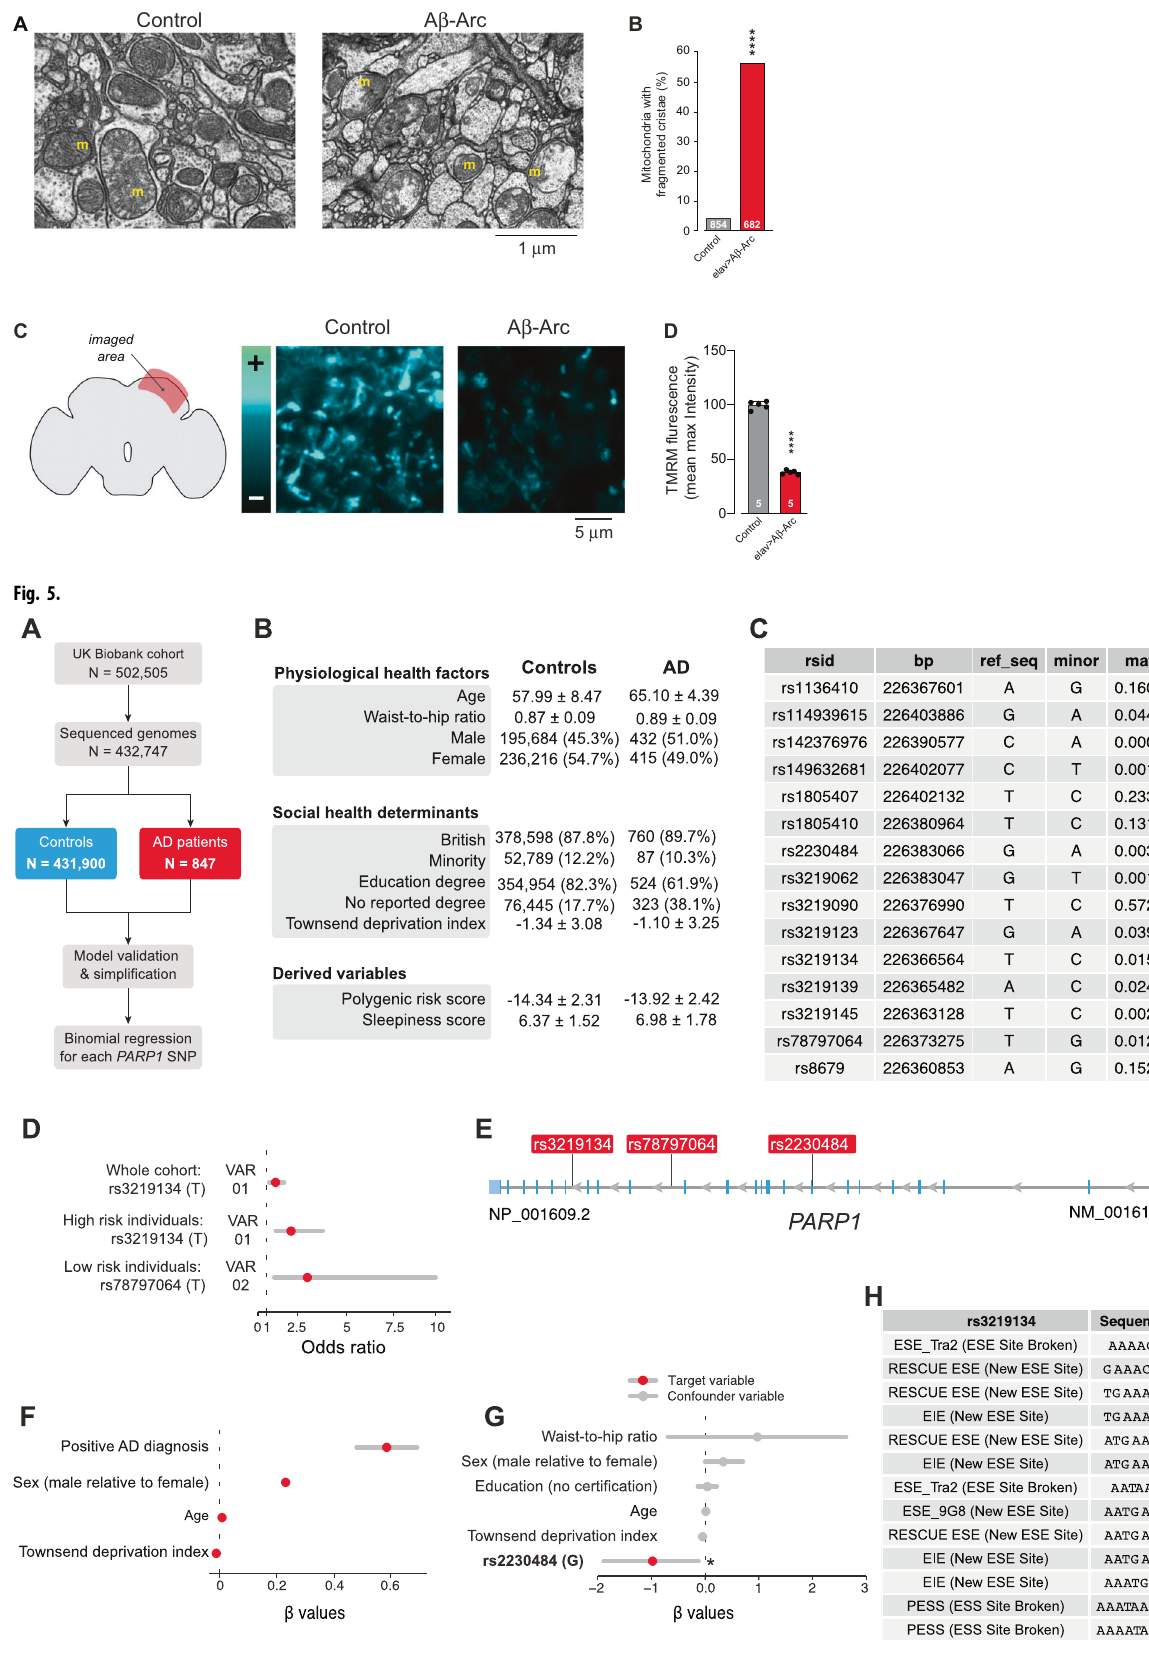
Cell Death and Disease (2021)